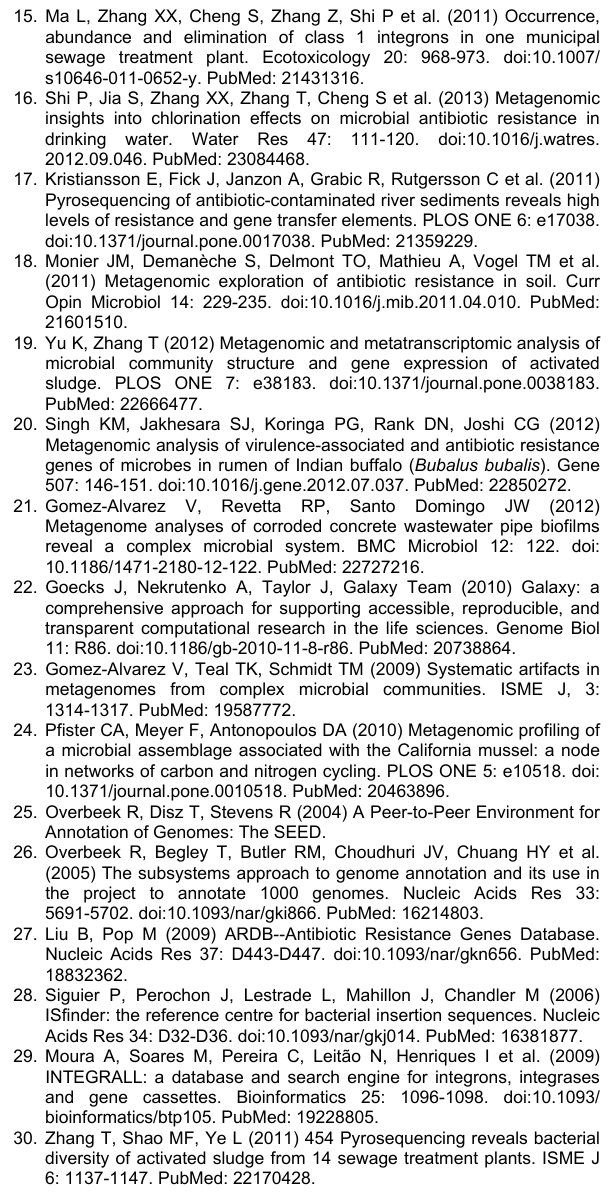
Table S7. Matched high-throughput sequencing reads of insertion sequences in anaerobic and aerobic sludge against ISfinder database. (Ranked by sequencing number of the identified insertion sequences in anaerobic